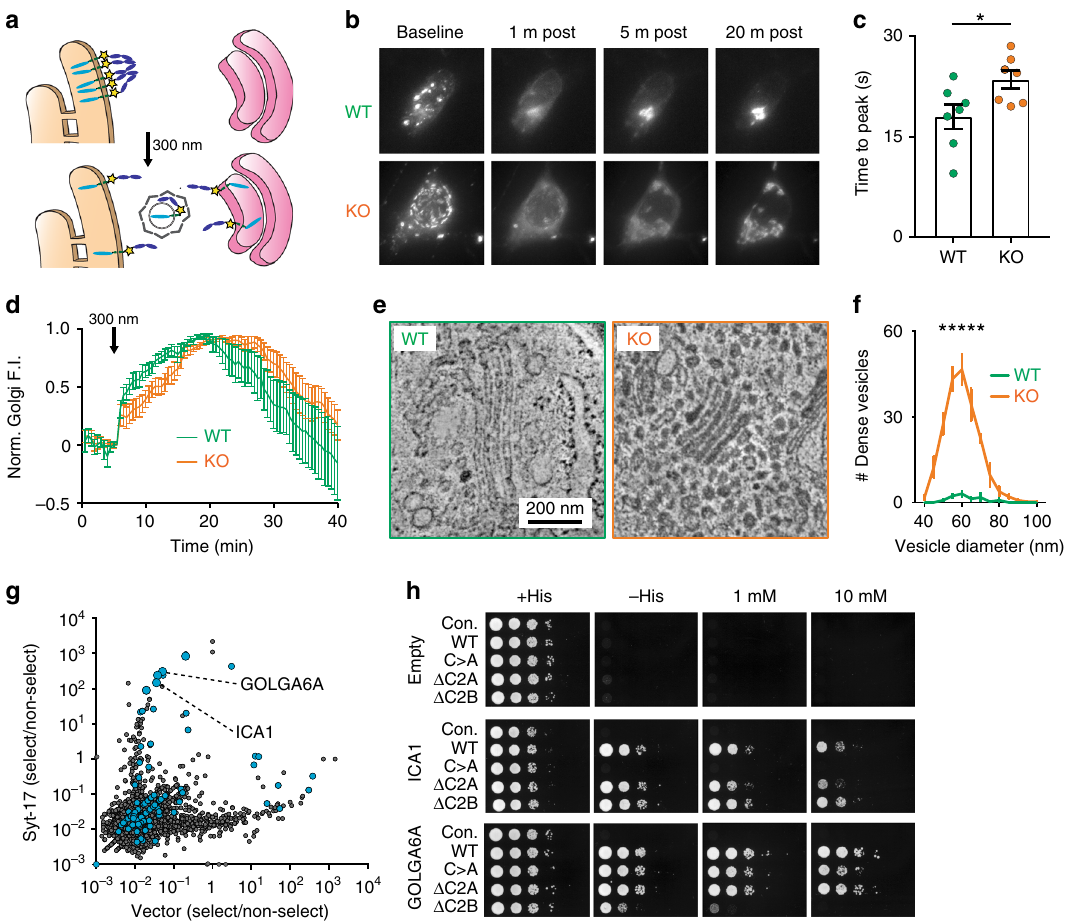
Fig. 5 Syt-17 regulates the early secretory pathway and interacts with Golgi resident proteins. a VSVG-YFP-2xUVR8 aggregates in the ER in the dark (top), disaggregates upon illumination at 300 nm, and is traf fi cked to the Golgi (bottom). b Representative images of uncaging and accumulation in WT and KO neurons. c Syt-17 KOs exhibit a slower time to peak Golgi fl uorescence ( t 12 = 2.425, p = 0.03, r 2 = 0.329, mean wt = 18 ± 1.84 s, mean ko = 23 ± 1.33, N wt = 7 and N ko = 7 neurons). d Time course for each cell. In KO neurons (orange) cargo accumulates more slowly. Measurements made from three independent preparations. All error bars indicate S.E.M.s. e Representative electron micrograph of the somatic Golgi complex in WT (left) and KO (right) neurons, demonstrating vesicle accumulation in the KO. Scale bar indicates 200 nm. f Histogram of vesicle diameters quanti fi ed across four fi elds of view from two litters of mice. Error bars indicate S.E.M.s. g Result of a DEEPN analysis for syt-17 interactors. Plotted is the ratio of each gene abundance in the selected (-His grown) sub-population vs. the non-selected ( + His) subpopulation (see Methods section). Genes for which the majority of plasmids were in the proper reading frame with respect to the Gal4 activation domain (i.e., potential interactors) are shown in blue. Two Golgi proteins among the top hits, GOLGA6A and ICA1, are indicated. h Binary yeast two-hybrid assays showing interaction of full-length (WT) syt-17, and the indicated syt-17 mutants, with Golgi proteins GOLGA6A and ICA1. Incubations with 1 mM and 10 mM of 3-aminitriazole (see Methods) are shown on